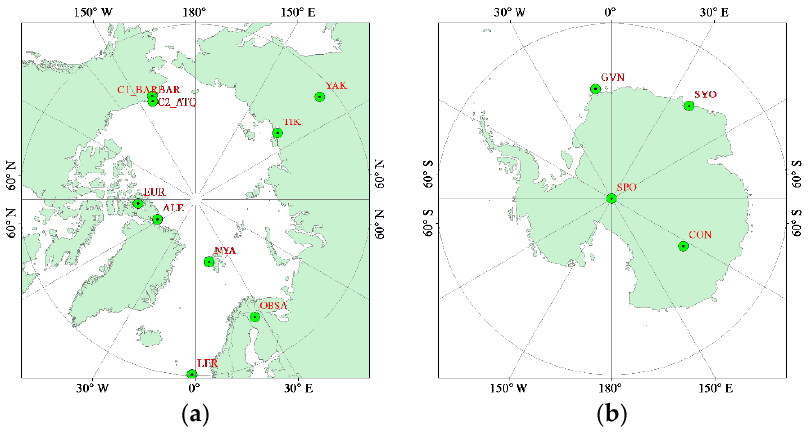
Figure 1. Ground sites distribution in polar regions. ( a ) Arctic; ( b ) Antarctic. Table 2. Geographic information of 14 ground sites in polar regions.